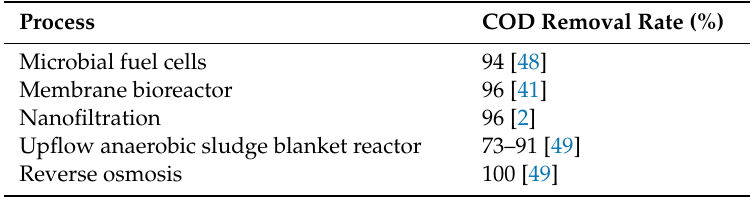
Table 4. Treatment methods used for brewery e ffl uent and the e ffi cient removal of chemical oxygen demands